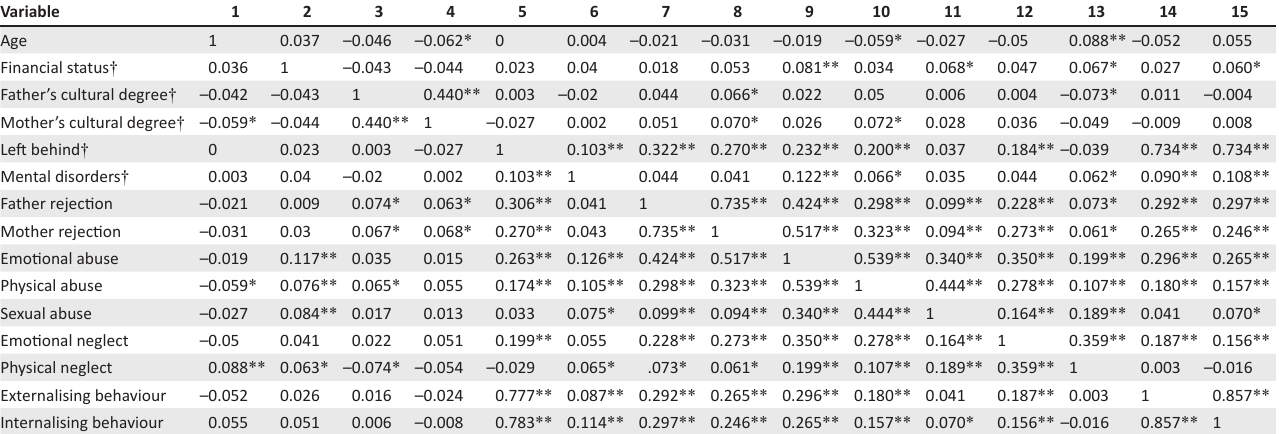
TABLE 3: Correlation coefficients for all variables of interest in female sample ( n = 1179). Variable